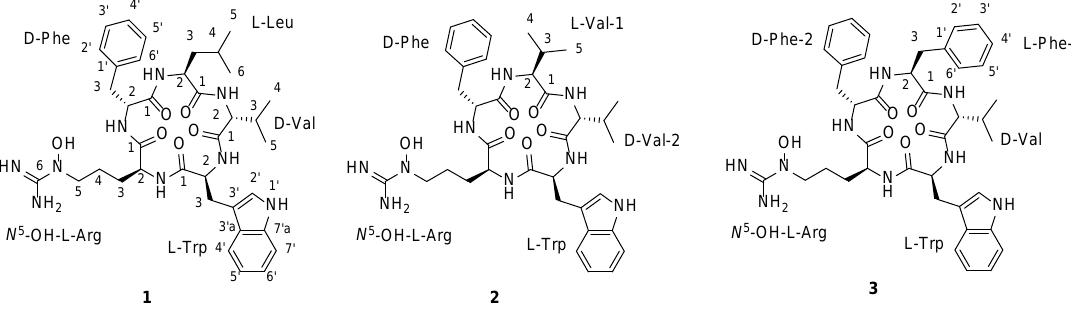
Figure 1. Structures of pentaminomycins C–E ( 1 – 3 ).